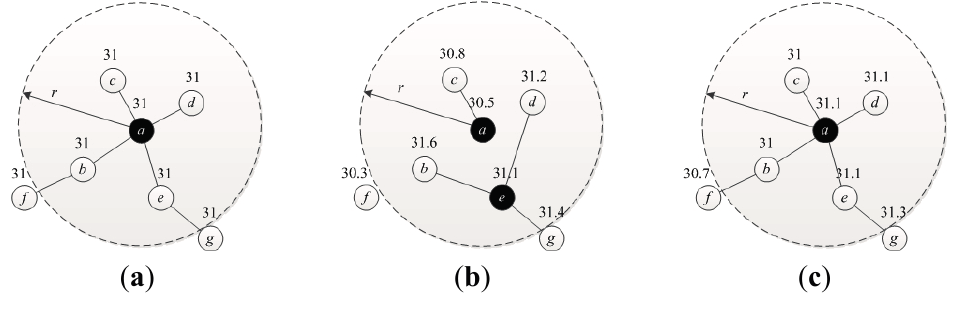
Figure 2. An example of the representative node selection scheme: ( a ) using noise-free data; ( b ) using noise-corrupted data; ( c ) using denoised